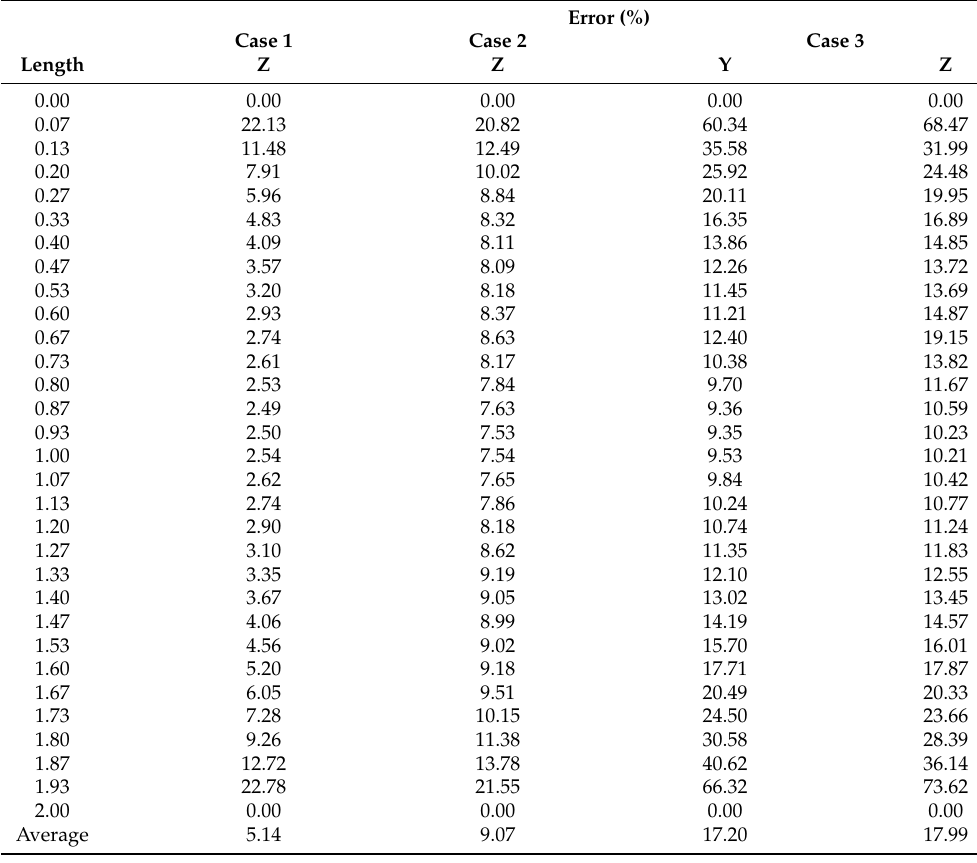
Table A3. Ful error table for two pinned supports